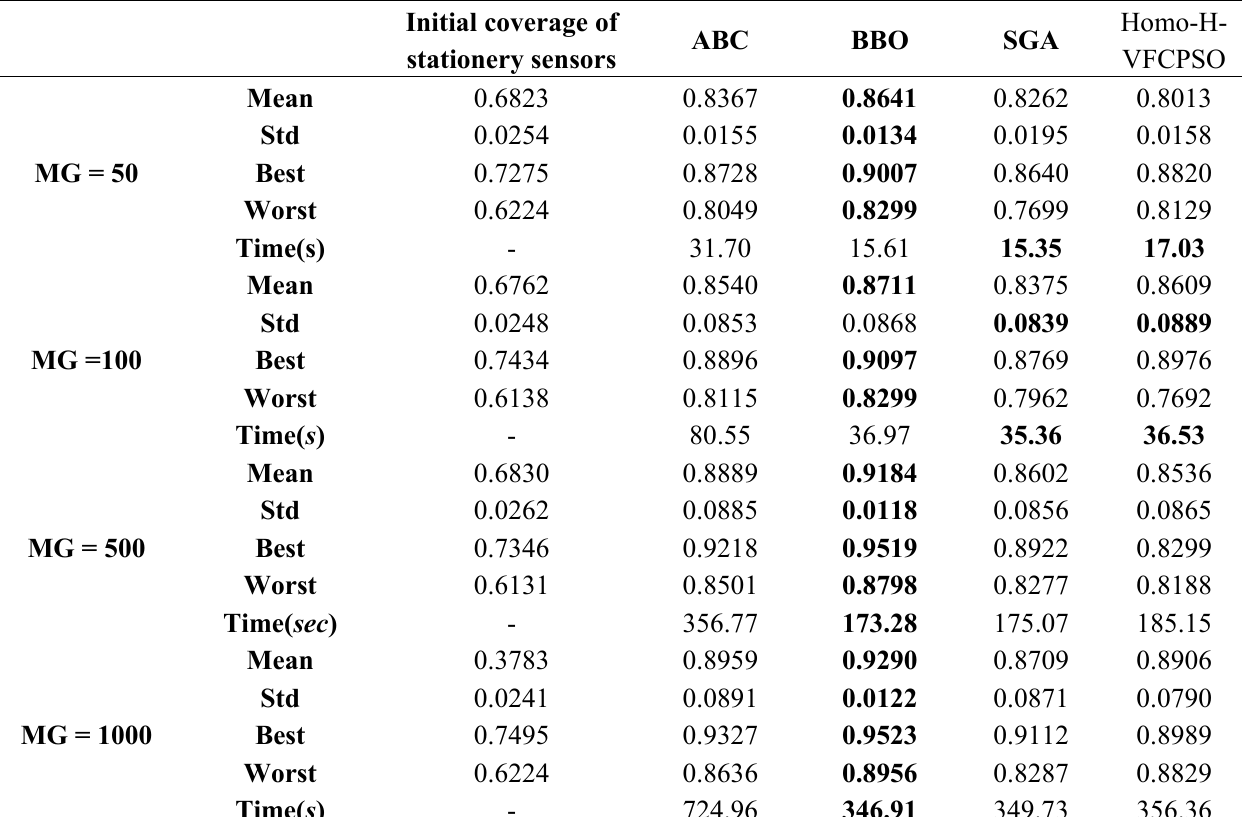
Table 2. Binary Dynamic Deployment Results on Different Iterations.